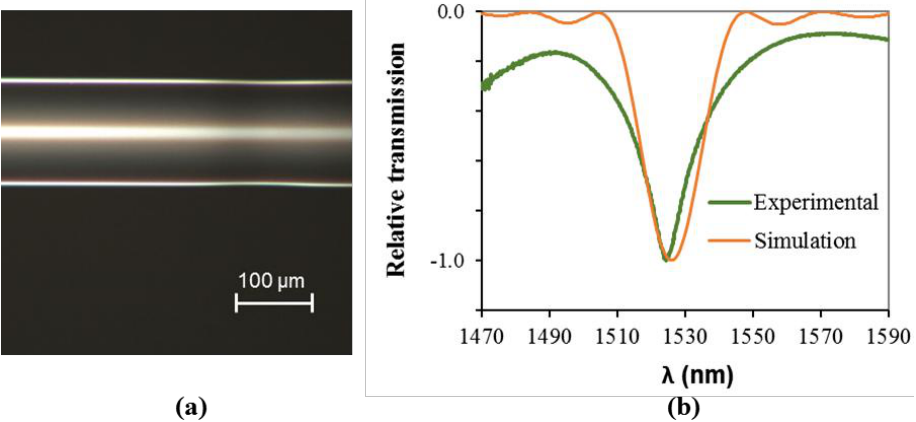
Figure 11. ( a ) Picture showing an irradiated zone from a 25 mm LPFG with 500 μm period and ( b ) experimentally obtained and simulated relative normalized spectral transmission. ( P = 6 W; τ = 0.6 s; F = 0.461